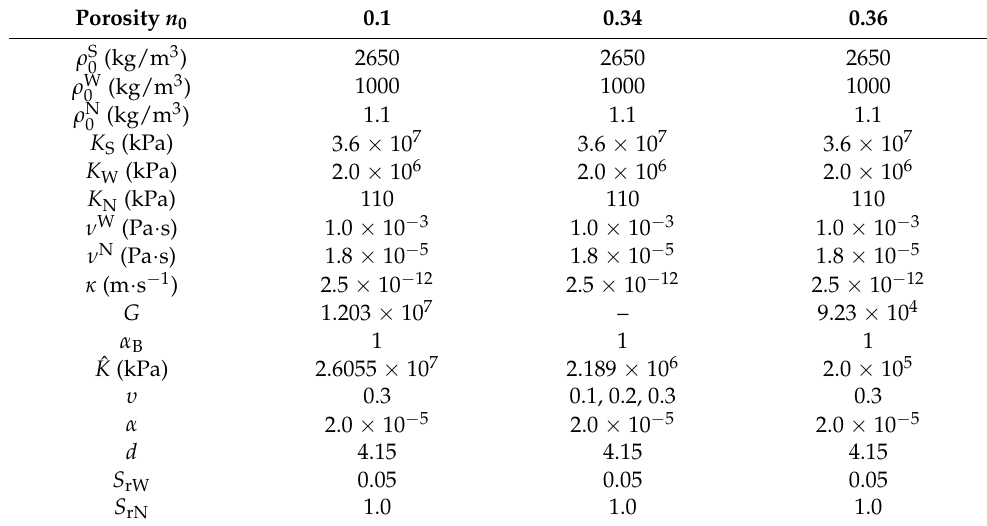
Table 1. Material parameters of the unsaturated porous medium.